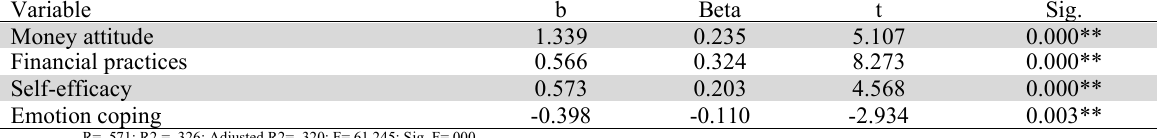
Results of multiple regression analysis for the determinants of